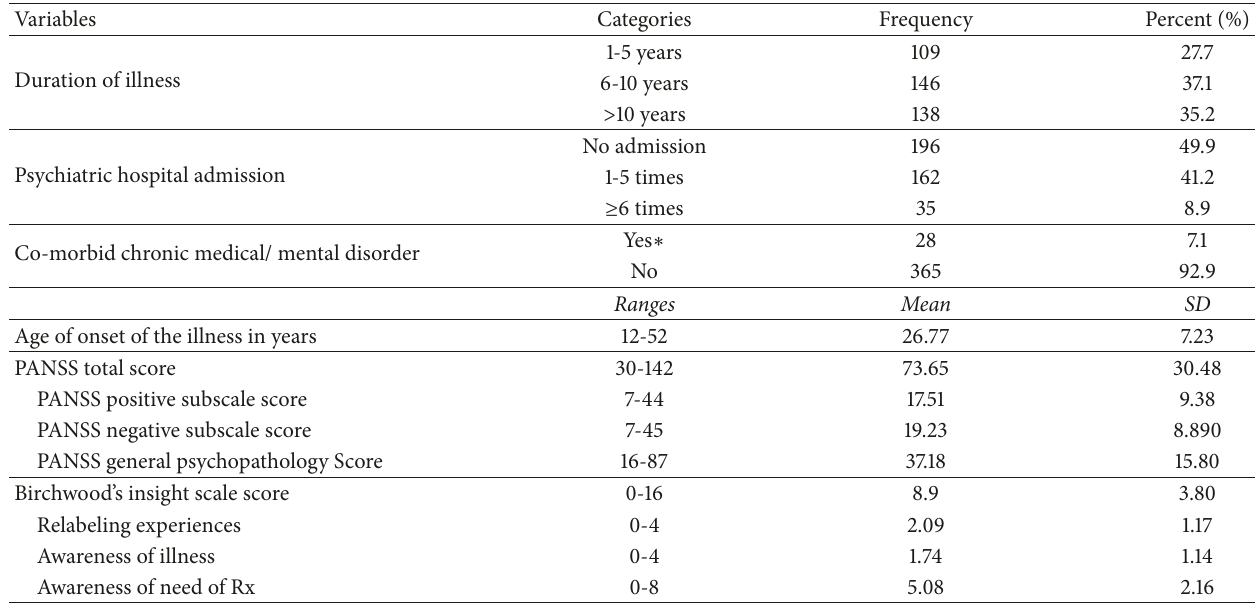
Table 2: Clinical characteristics of patients with schizophrenia on follow-up at AMSH, 2018 (n=393).